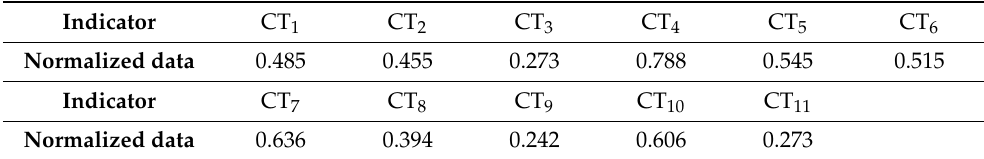
Table A3. Normalized data of construction technical risk